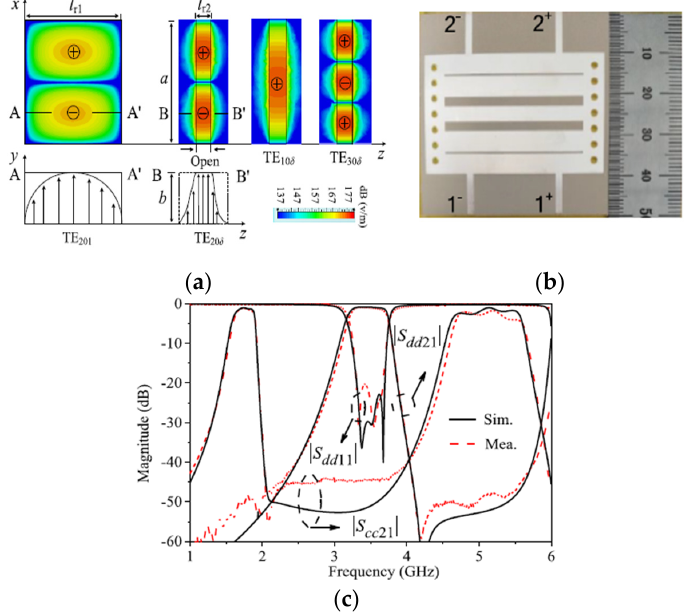
Figure 7. The proposed balanced BPF [50]: ( a ) Current distribution; ( b ) Photograph of the fabricated prototypes; ( c ) Simulated and measured s-parameters.